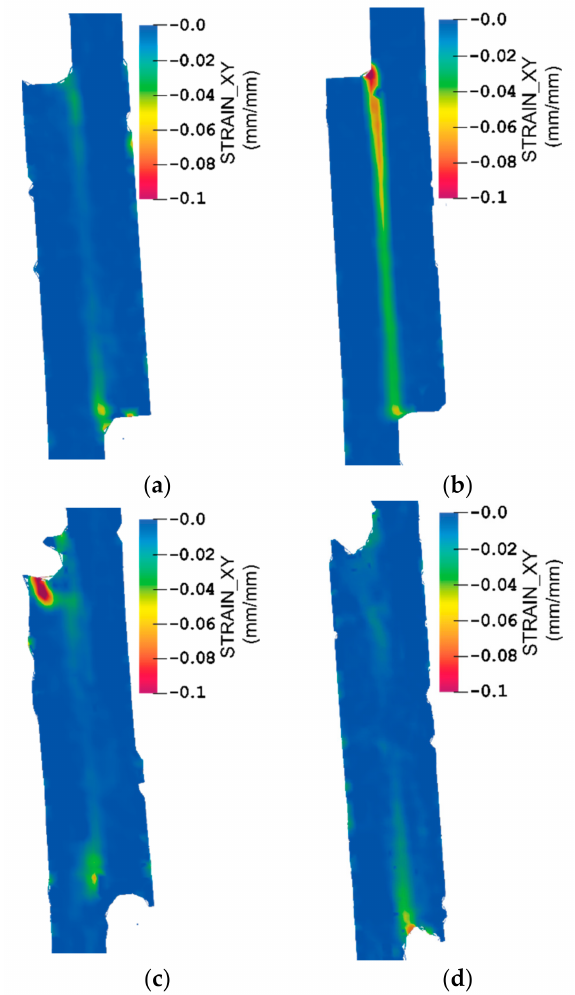
Figure 13. Pre-failure Cauchy strain_xy fields of representative ( a ) VTFA400 specimens ( b ) cured and bonded ( c ) co-cured; and ( d ) Z-pinned.